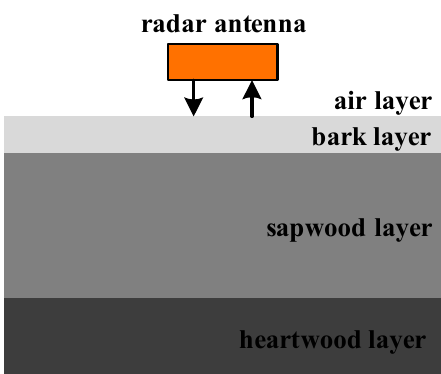
Figure 1. The sketch map of GPR detection.